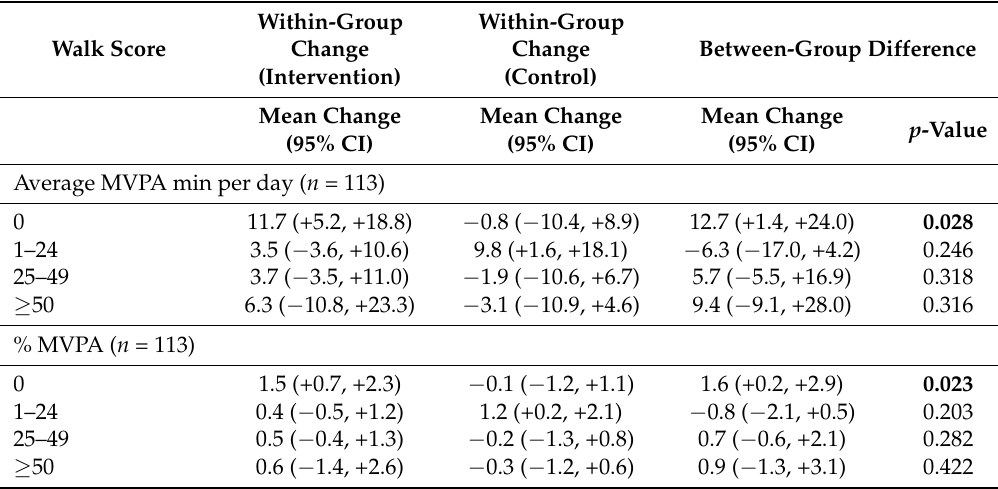
Table 3. Walk Score between-group